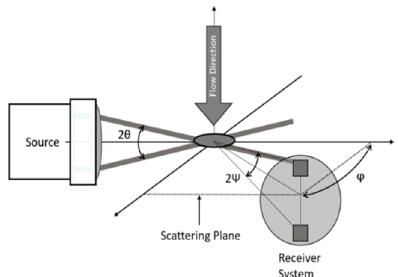
Figure 3. Scheme of a classical PDI setting, where θ , ψ , and φ are the beam intersection angle, elevation angle, and scattering angle.